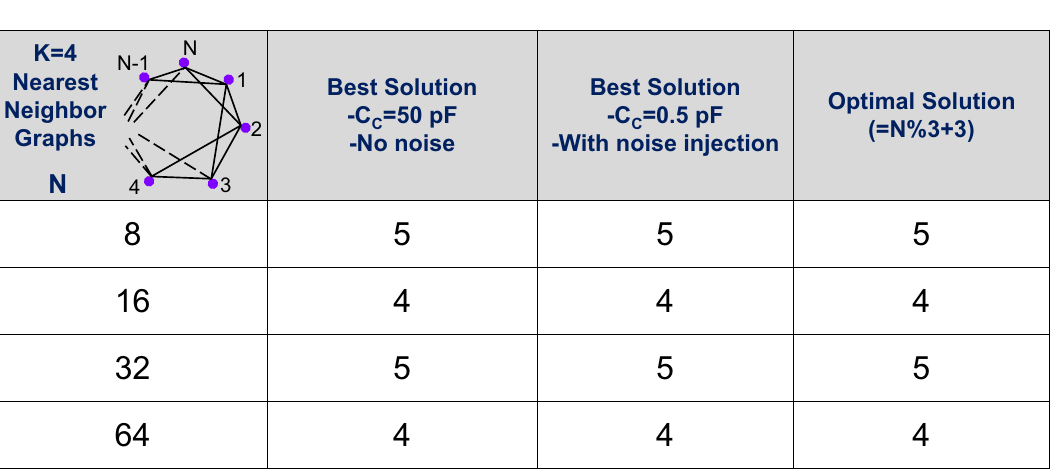
Figure 5. Simulations showing coloring of K = 4 nearest neighbor graphs of various size (N) using the coupled oscillators, with and without the injection of noise (180 mV RMS ). It can be observed that the injection of noise reduces the required capacitance to observe frequency locking and the corresponding computation relevant phase properties. C C = 50pF (without noise) and C C = 0.5pF (with noise) were chosen since stable frequency locking at these values for all the analyzed graphs. With C C = 0.5pF, the system does not exhibit synchronization before the injection of